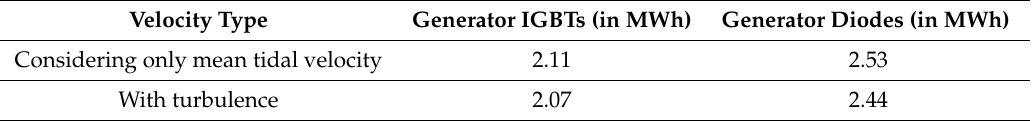
Table 8. Annual Generator Side Converter Loss (includes losses for all phases).